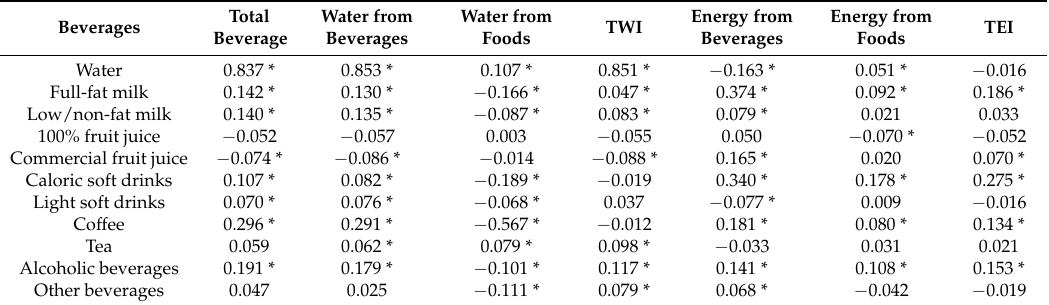
Table 5. Partial correlation between the consumption of different types of beverages and TWI, water from beverages and foods, TEI, energy intake from beverages and foods (adjusted for gender, age, BMI, and